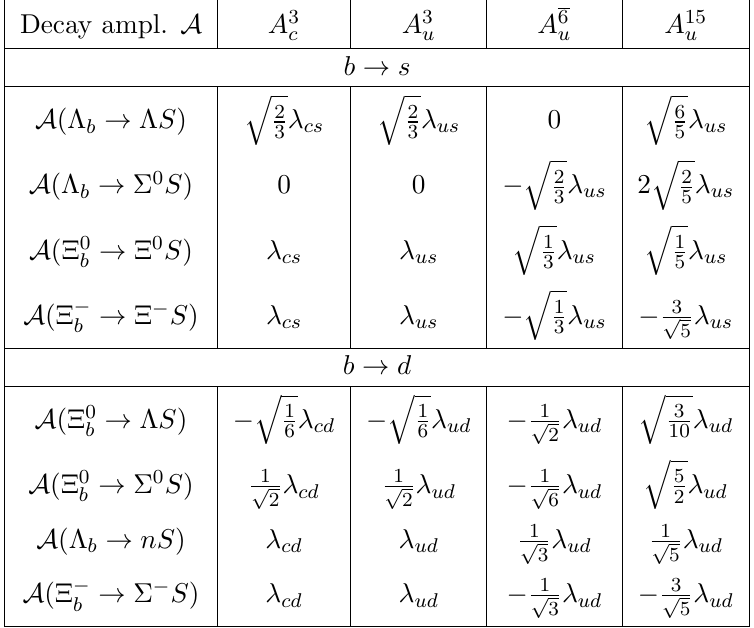
Table 2. SU(3) F -limit decomposition.